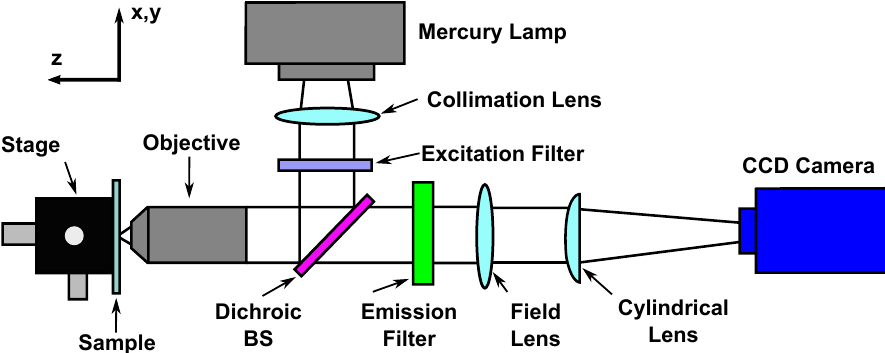
Figure 3. Schematic of a particle tracking velocimetry (PTV) setup used to quantify the transient swelling of hydrogels in three dimensions [97]; adapted from [96]. Placing a cylindrical lens in front of the CCD (charge-coupled device) camera creates an anamorphic imaging system, resulting in different optical properties in the x and y directions. Combining the x and y projections allows for the information of the z-dimension to be calculated [102]. (BS =